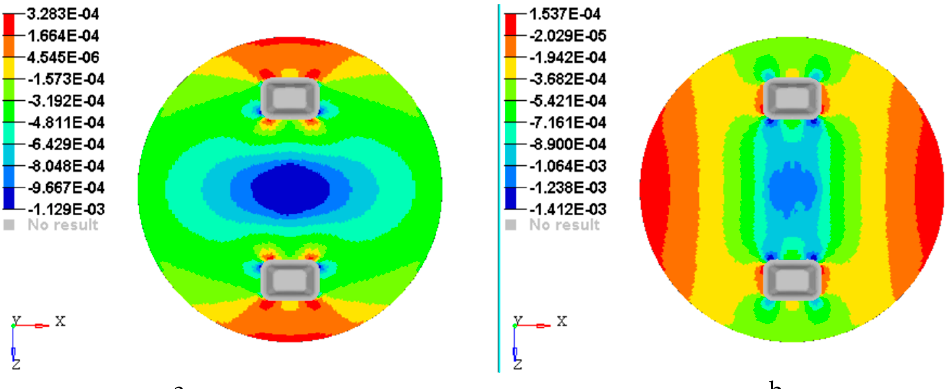
a. b. Figure 15. Plot of the strains on the interface between layer 2 and 3: ( a ) Strains ε x with respect to Ox axis; ( b ) strains ε z with respect to Oz axis.